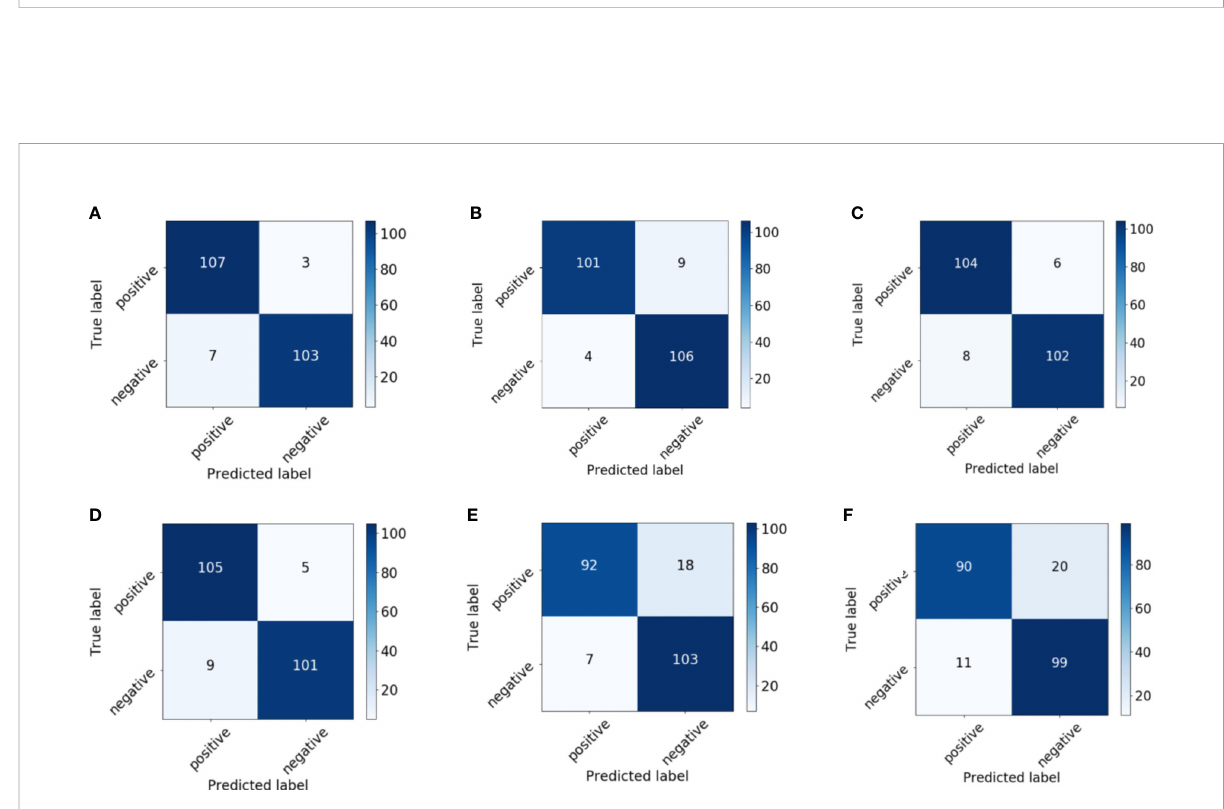
FIGURE 7 Confusion matrix of the proposed network with (A) ResNet-18, (B) ResNet-50, (C) VGG-11, (D) VGG-16, (E) DenseNet-121, and (F) DenseNet-201